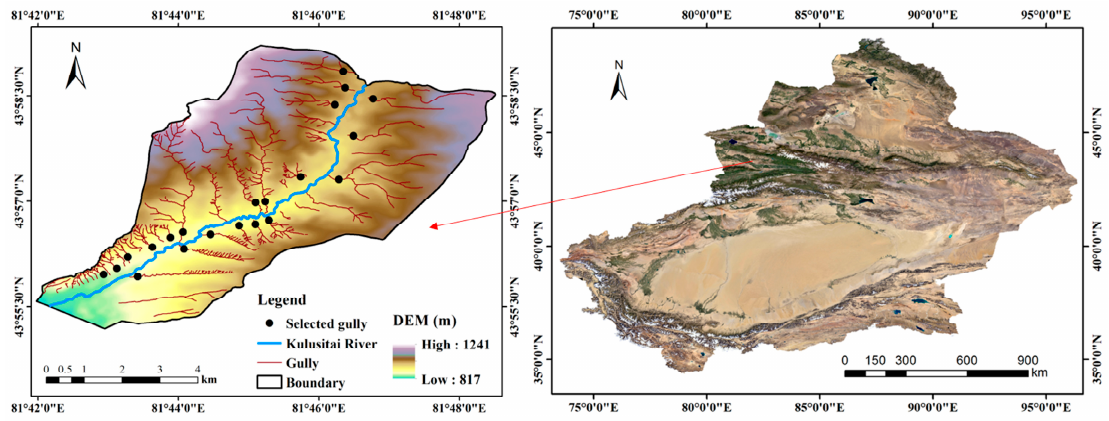
Figure 1. Location of study area and selected gullies.